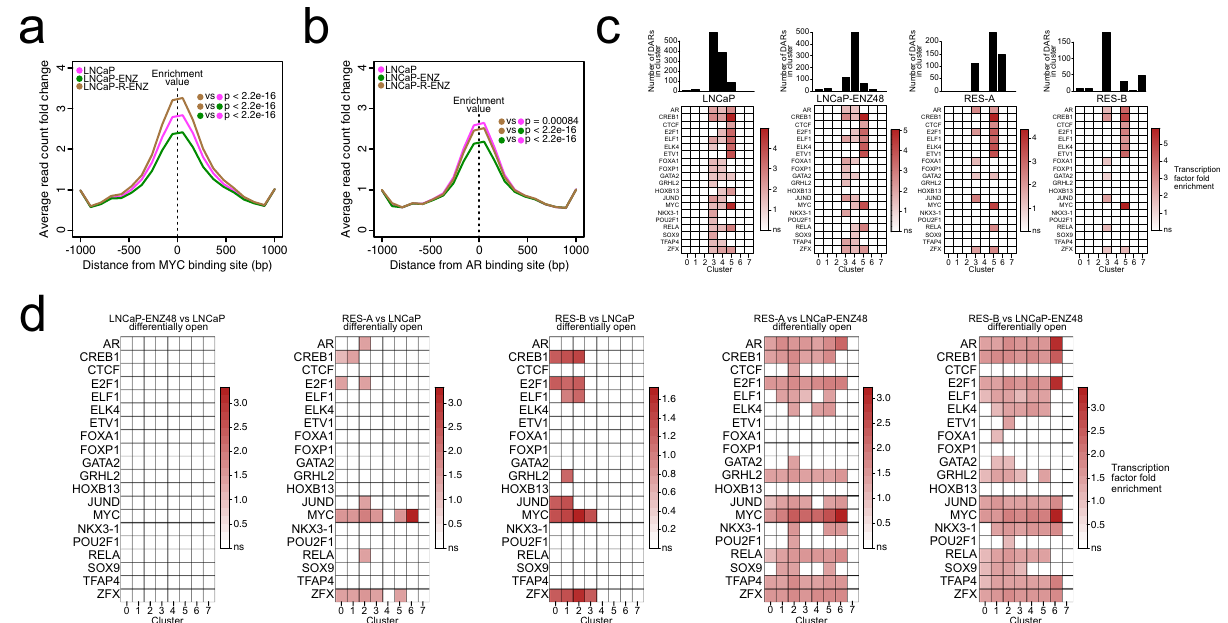
Fig. 2 Contribution of enzalutamide treatment-mediated chromatin reprogramming to transcription factor DNA motif footprint. a , b Normalized average formaldehyde-assisted isolation of regulatory element (FAIRE)-seq read distribution in androgen-deprived conditions within a 2-kb interval around a MYC-binding sites and b AR-binding sites in LNCaP cells. Sample comparisons of enrichment values at the middle of the distribution are indicated using colored dots within the plots and the two-sided t -test p -value is shown. c Prostate cancer-associated transcription factor (TF) motif enrichment in open differentially accessible regions (DARs) for each single-cell ATAC-seq sample. Enrichments with a Benjamini – Hochberg method-adjusted hypergeometric test p -value < 0.05 are shown in colors, while nonsigni fi cant (ns) enrichments are shown in white. The barplots above the matrices indicate the number of open DARs found for each cluster in each sample. d TF motif enrichments in open DARs observed comparing the indicated conditions. Enrichments with a Benjamini – Hochberg method-adjusted hypergeometric test p -value < 0.05 are shown in colors, while nonsigni fi cant (ns) enrichments are shown in white. See also Supplementary Fig. independent ENZ-resistant (RES-C) LNCaP-derived cell line